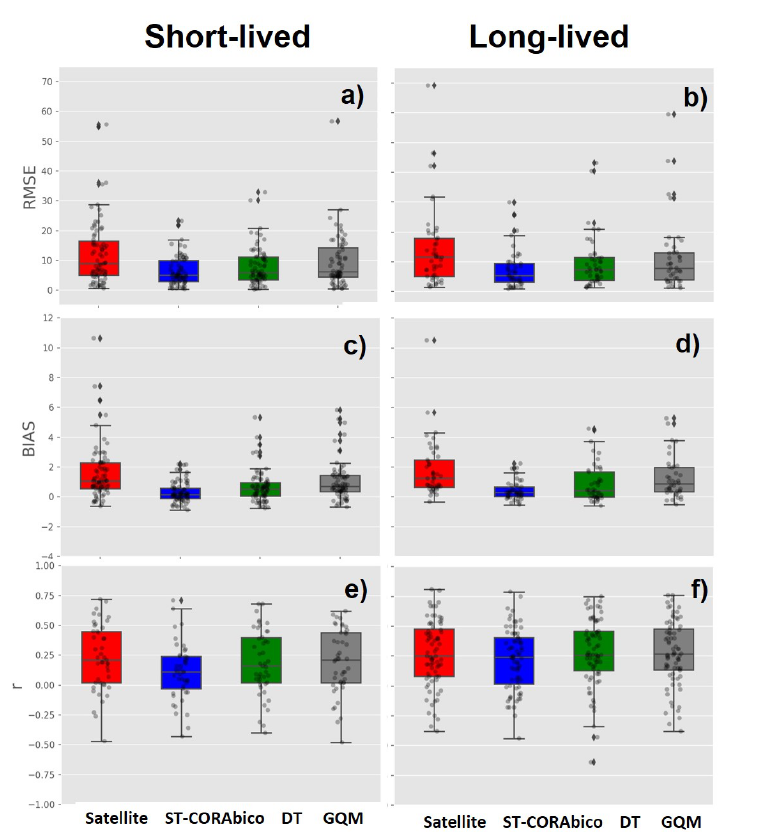
Figure 10. Comparison between the satellite GPM-IMERG (red), ST-CORAbico (blue), Distribution Transformation (green) and Gamma Quantile Mapping (grey) error dispersion during monsoon seasons 2014–2017. ( a , b ) RMSE; ( c , d ) bias; and, ( e , f ) correlation